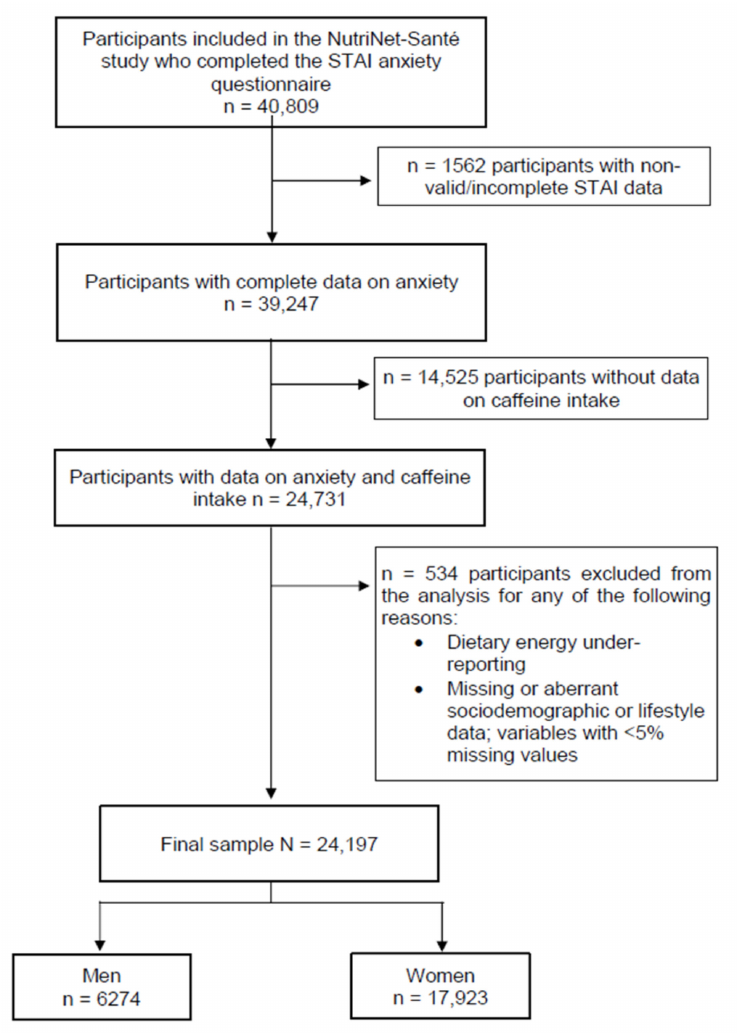
Figure 1. Participant flow diagram for NutriNet-Sant é e-cohort participants included in the current analysis. Abbreviations: STAI-T, Spielberger’s State-Trait Anxiety Inventory Form